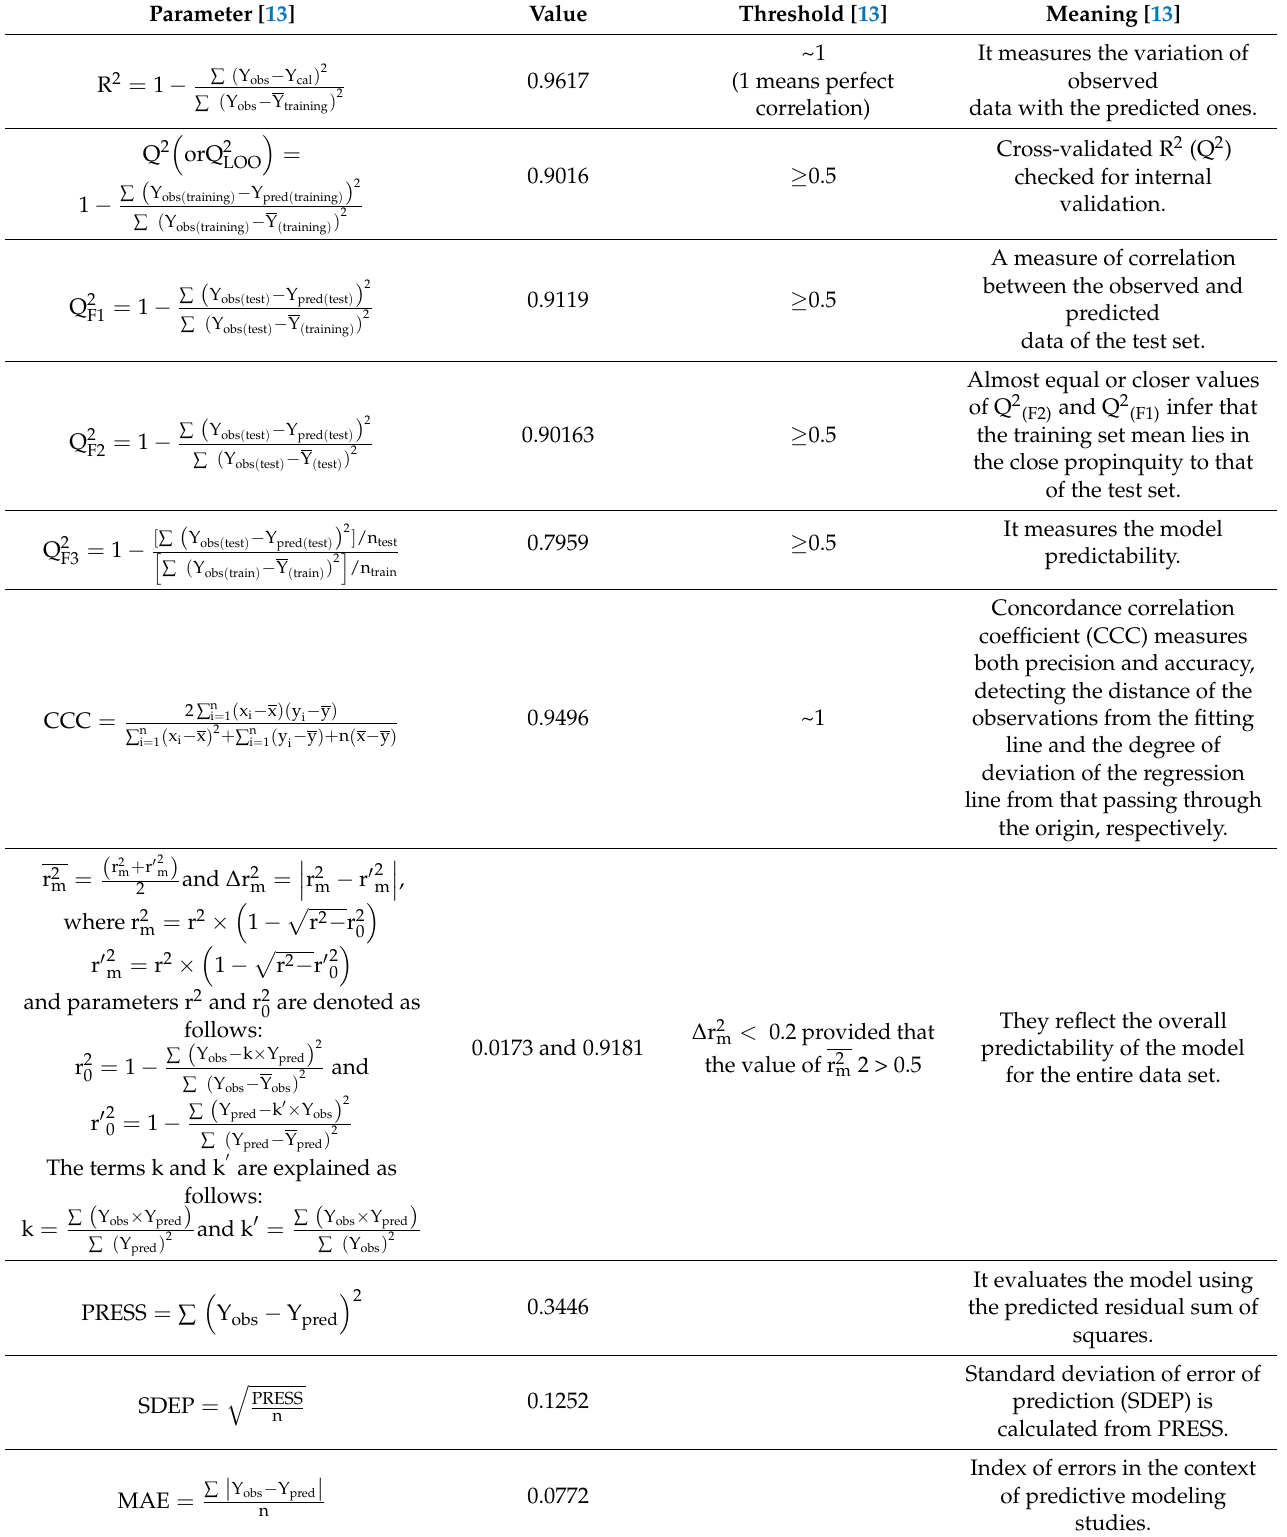
Table 5. Values of validation parameters of the optimal MARS